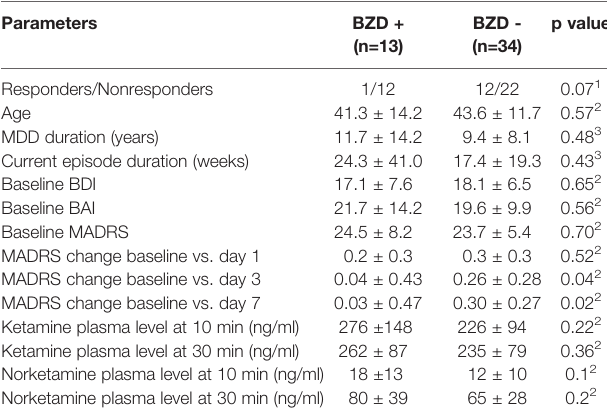
TABLE 2 | Characteristics of high-dose benzodiazepines (BZD) users (BZD+; >8mg of DE) and none-to-low-dose BZD users (BZD-; 0 – 8mg of DE) during the follow-up